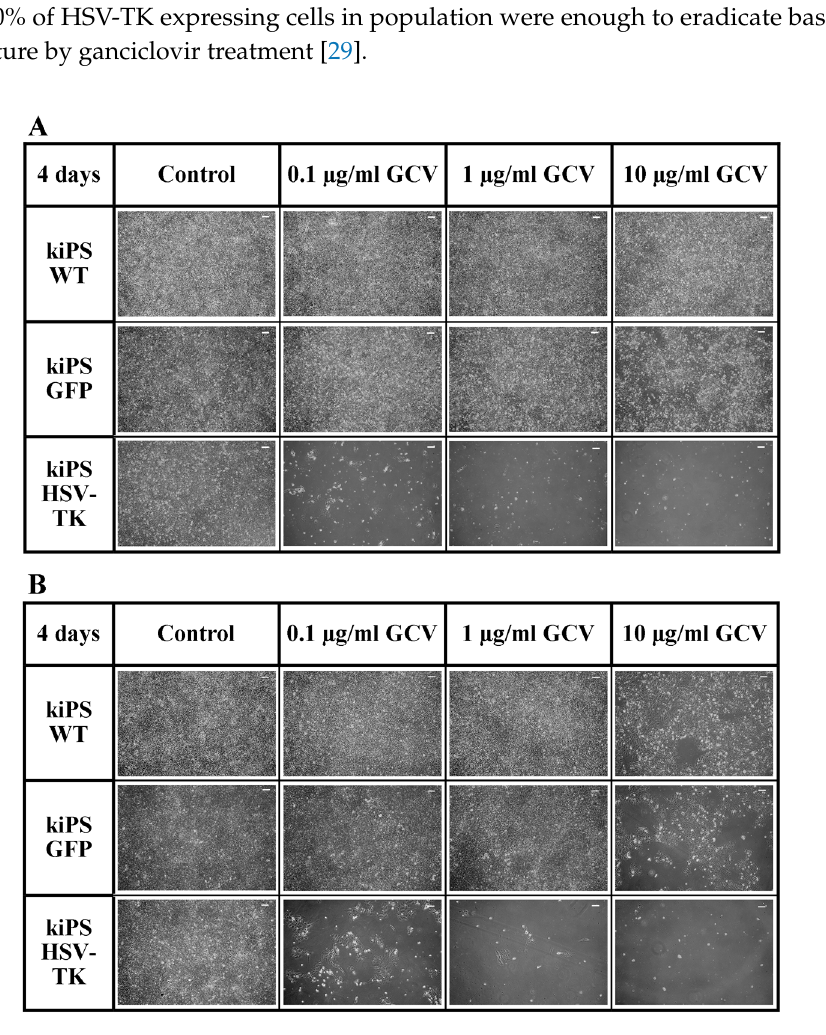
Figure 5. Ganciclovir efficiently eliminates HSV-TK expressing kiPS cells in vitro. ( A ) Four days of treatment with 0.1, 1 and 10 µg/mL ganciclovir (GCV). All sorted HSV-TK-expressing kiPS cells were eliminated while control cells (kiPS WT and kiPS GFP) remained intact despite mild non-specific toxicity in highest GCV dose. ( B ) Four days of treatment with 0.1, 1 and 10 µg/mL ganciclovir (GCV). Almost all unsorted HSV-TK-expressing kiPS cells were eliminated while control cells (kiPS WT and kiPS GFP) remained intact. All images: magnification 100×, and white bars represent 100 µm.